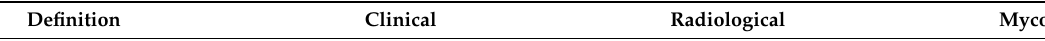
Table 1. Definition of